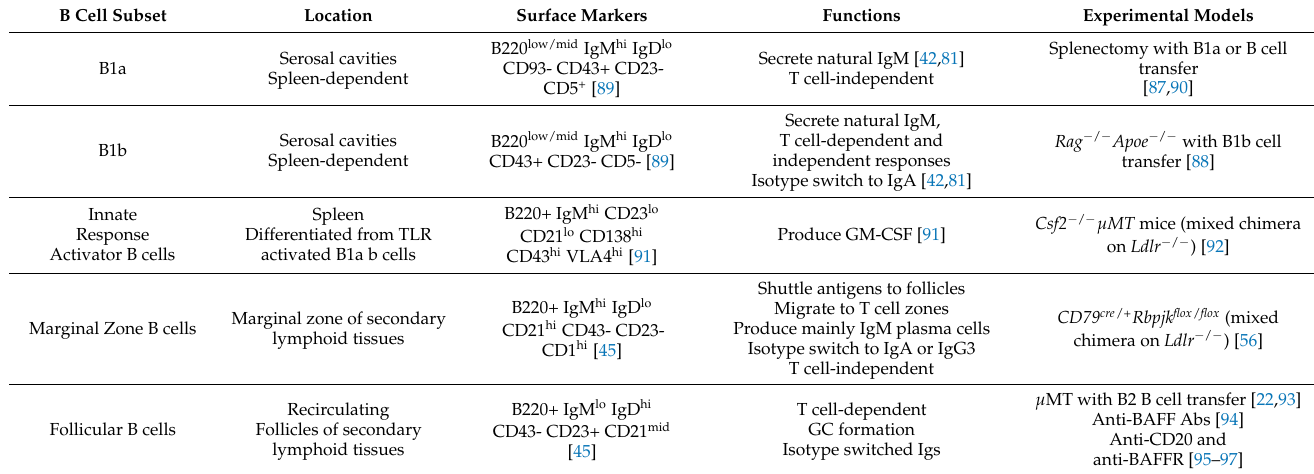
Table 1. Characteristics of B cell